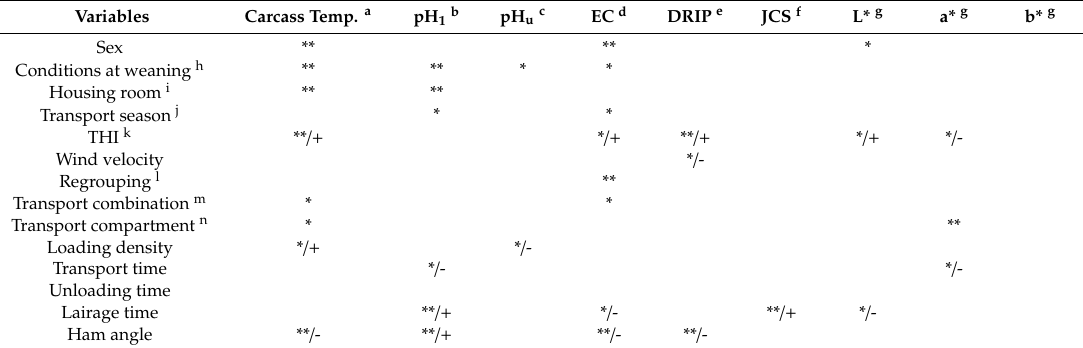
Table 4. An overview of factors influencing the meat quality parameters of 2404 slaughtered pigs.